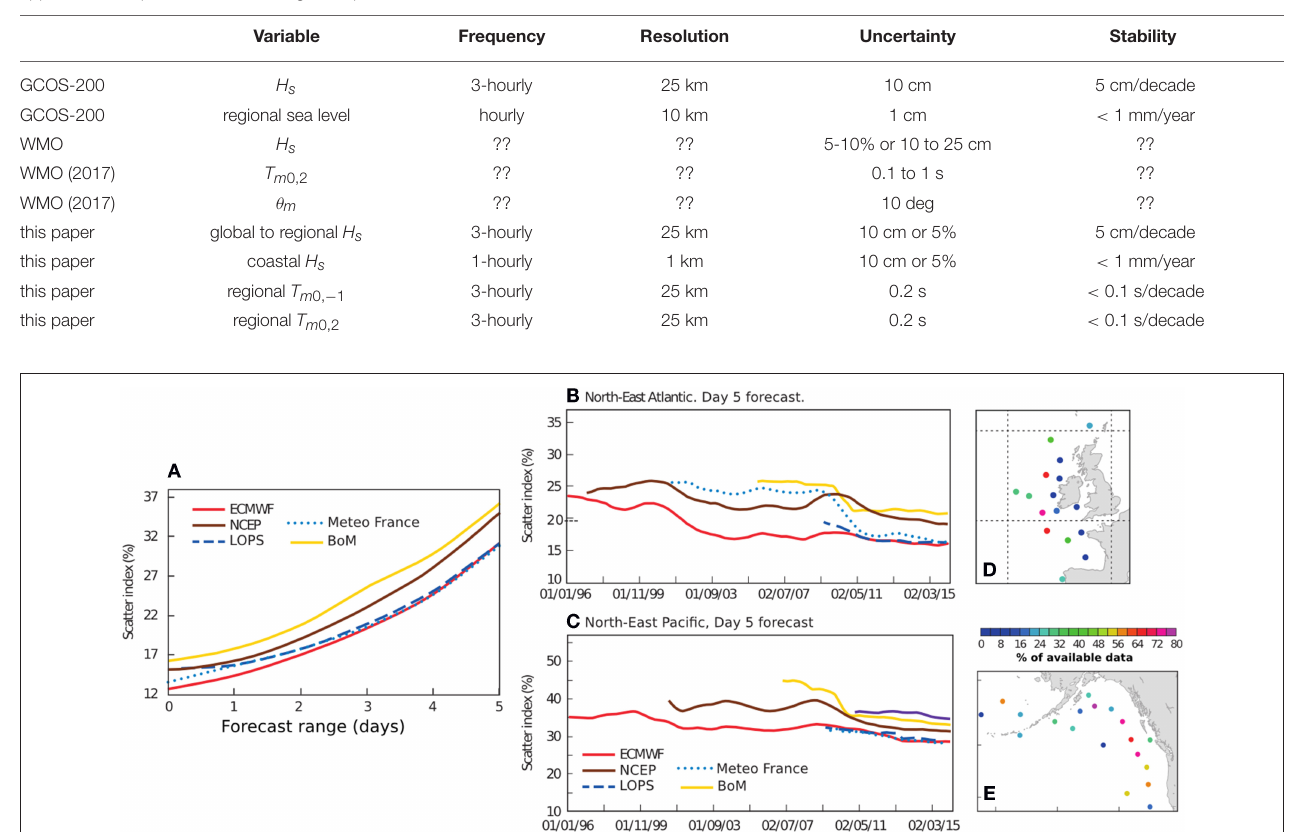
TABLE 1 | Requirements on sea state measurements according to GCOS-200, and propositions for updates. The requirements on stability should be understood as applicable to all percentiles of the heights or period distributions.